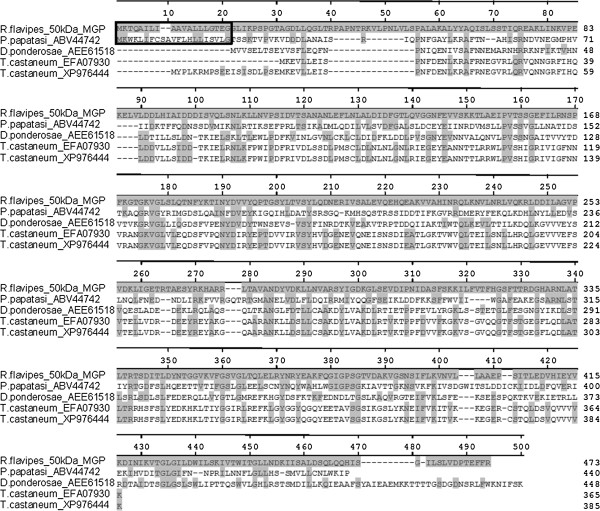
A ClustalW multiple alignment of homologous 50 kDa
Midgut Protein sequences from various insects,
including R. flavipes (current study),
Phlebotomous papatasi (GenBank accession
No. ABV44742), Dendroctonus ponderosae
(AEE61518) and Tribolium castaneum
(EFA 07930, XP976444).  Gray shaded amino acids are
identical to the R. flavipes sequence. Signal peptides for the
R. flavipes and P. papatasi sequences are enclosed
in boxes.